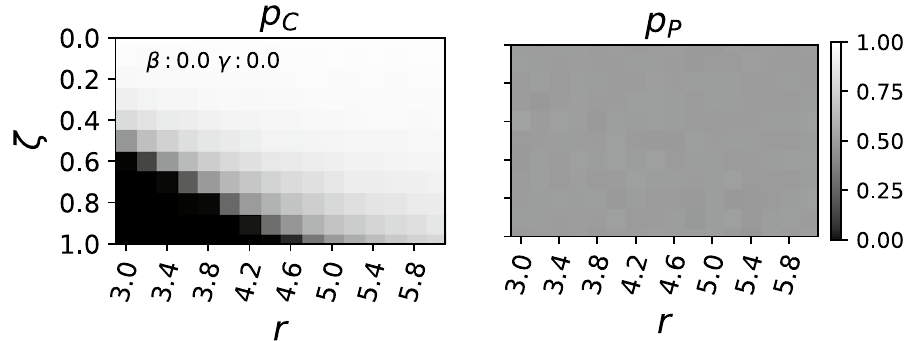
Figure 1. Phase diagram for evolved strategies under varying conditions. In order to model the absence of punishment β and γ were set to 0.0 while the synergy factor r (x-axis) and the degree to which payoffs were distributed individually ζ (y-axis) were varied. On the left the probability to cooperate at or after the point of convergence is shown, on the right the probability to punish. The color bar on the right shows that probabilities of 0.0 are black, and probabilities of 1.0 are displayed in white. For each square in the phase diagram 100 replicate evolutionary runs over 100.000 generation were